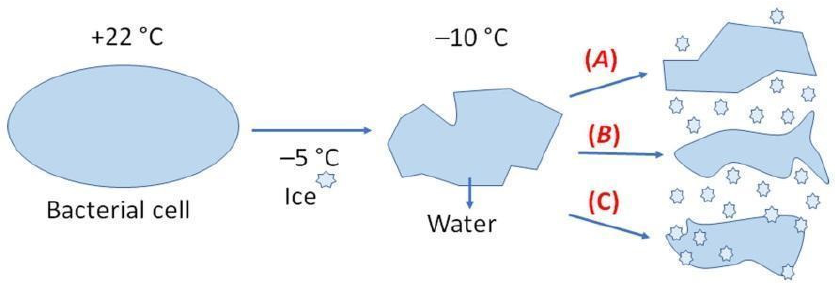
Figure 6. Schematic representation of the cellular response to freezing: ( A ) slow cooling, ( B ) optimal cooling, and ( C ) very fast cooling; data from Gao & Critser, 2000 [100]. Salinity and Temperature. Storing microorganisms in distilled water leads to a higher viability compared to cryopreservation in physiological NaCl solution [75]. This was ex- amined using E. coli 451-B [76]. The organism was frozen in either distilled water or 0.85% NaCl solution. Moreover, ultra-fast freezing to − 196 °C followed by slow or rapid heating, or slow cooling to − 22 °C and slow heating or rapid heating were examined. The viability of E. coli was up to 78% when distilled water and ultra-fast cooling and rapid thawing were used. Using the same freezing and thawing procedure but using NaCl solution re- sulted in 12% viability. In contrast, viability decreased to 48% with slow cooling to − 22 °C in distilled water and rapid heating, while viability was 41% when using NaCl solution [75].